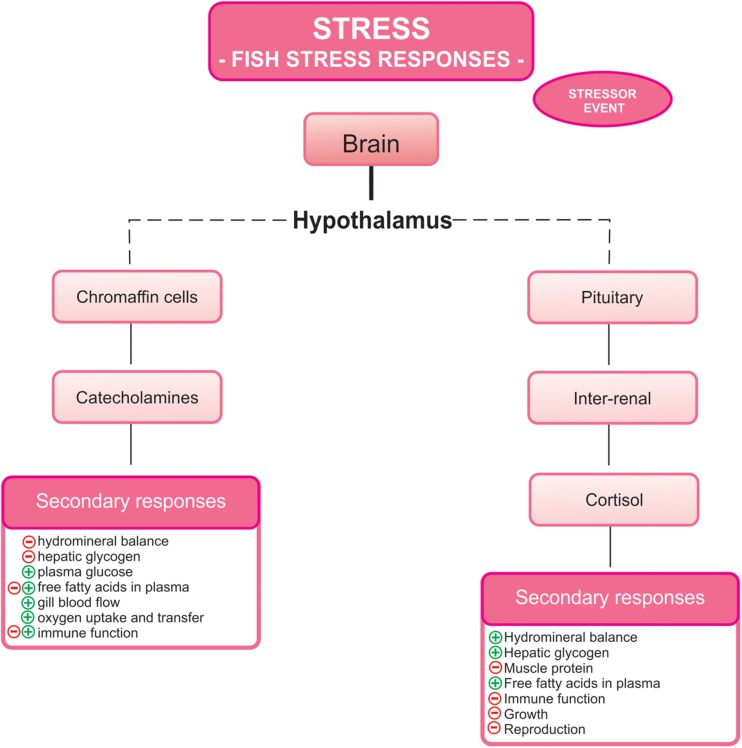
Responses to stress in fish. The activation of the hypothalamus-sympathetic-chromaffin and hypothalamus-pituitary-interrenal axes culminates in the release of catecholamines and cortisol, respectively. These hormones induced several stress secondary responses (modified from Wendelaar Bonga, 1997). (+) indicates activation and/or increase and (−) indicates inhibition and/or reduction.